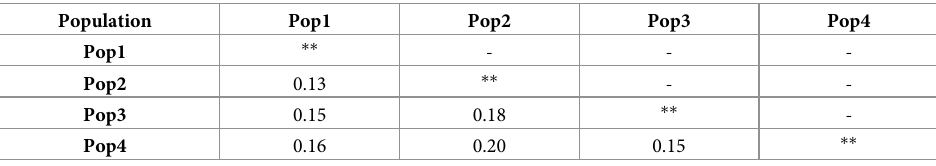
Table 5. Nei’s genetic distance among populations of wild ancient tea tree at different